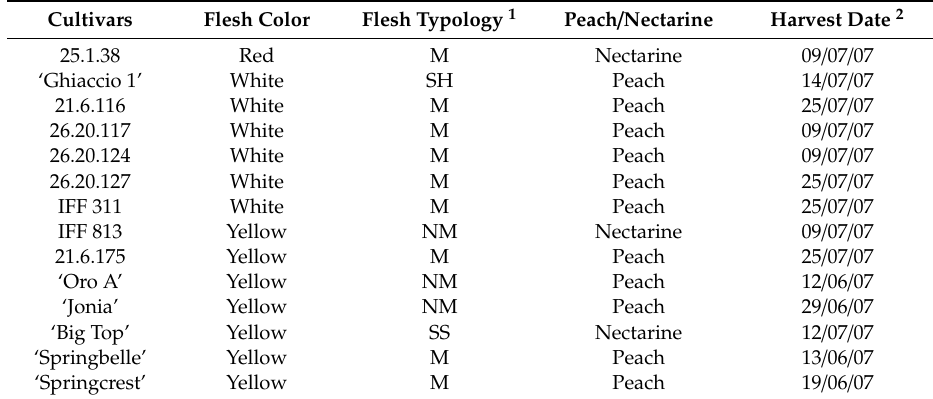
Table 1. The peach / nectarine commercial cultivars and breeding accessions used for evaluation in the trial with their associated flesh color, textural typology and harvest date in